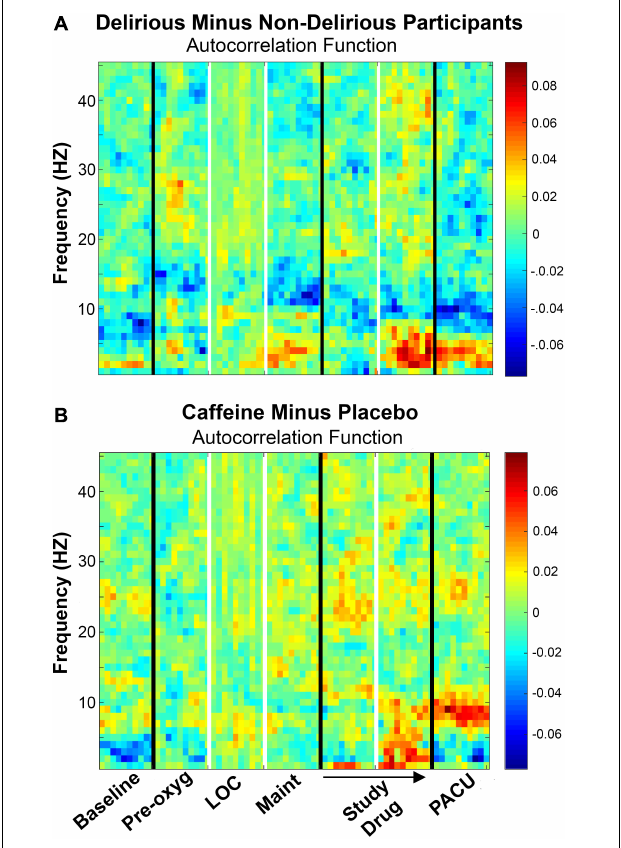
FIGURE 3 | (A) Autocorrelation function presented for non-delirious participants ( n = 42) subtracted from delirious participants ( n = 11) across study epochs. EEG data were obtained in the PACU after initial admission and nursing evaluation. During PACU evaluation, alpha (8 – 12) and high alpha (10 – 14 Hz) autocorrelation function were significantly reduced in delirious participants, and theta (4 – 8 Hz) autocorrelation function was significantly increased with delirium. (B) Autocorrelation function presented for caffeine ( n = 28) minus dextrose 5% in water placebo ( n = 27) participants. Participants receiving caffeine demonstrated significantly higher alpha (8 – 12 Hz) autocorrelation function during PACU recovery. Color bars represent median autocorrelation function differences between groups. Pre-oxy, pre-oxygenation; LOC, loss of consciousness; Maint, maintenance anesthesia phase; PACU, postanesthesia care unit; PLE, phase lag